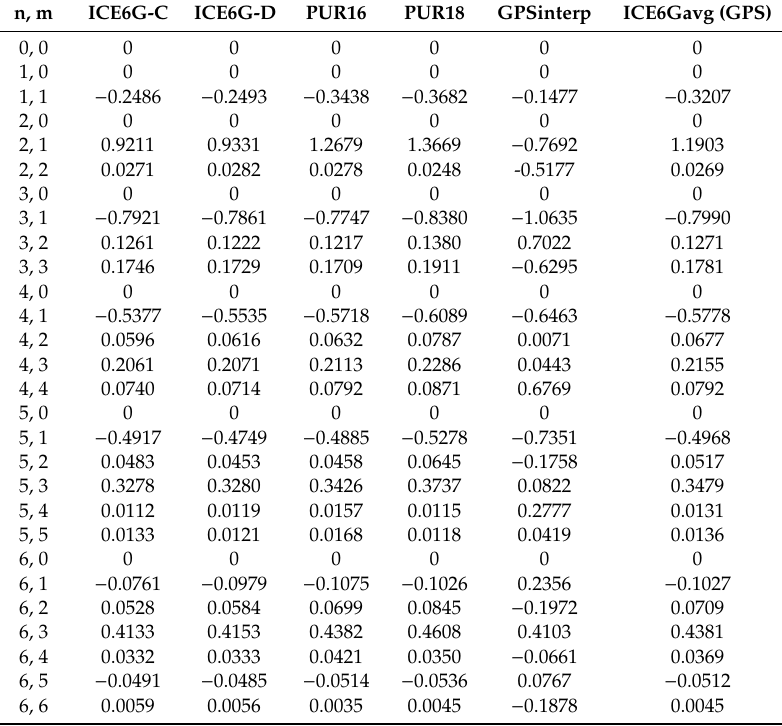
. X − 11 yr − 1 ) 1 S nm (Unit: 10